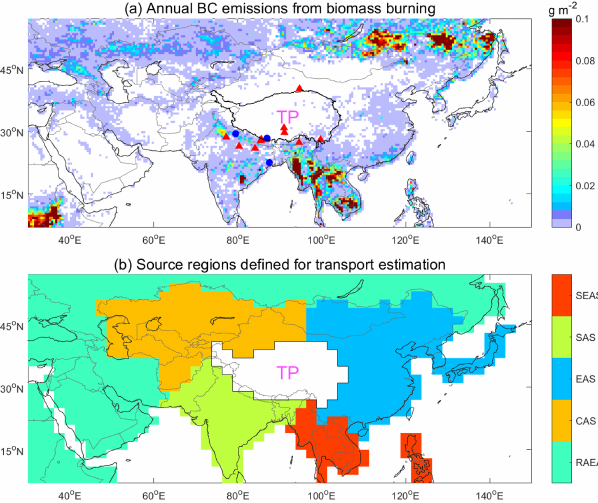
Figure 1. (a) Annual BC emissions from biomass burning averaged over 1997–2011 from GFED3. Red triangles (for Table S1) and blue dots (for Table S1 and Fig. S1) indicate the locations of the observa- tion sites used for model evaluation in the Supplement. (b) Source regions defined for the estimation of BC transport to the TP. The ab- breviations are for central Asia (CAS); East Asia (EAS); South Asia (SAS); South East Asia (SEAS); and the region of the rest of Asia, Europe, and Africa (RAEA). The dark black line in (a) encloses the domain of the TP, corresponding the white areas in (b)